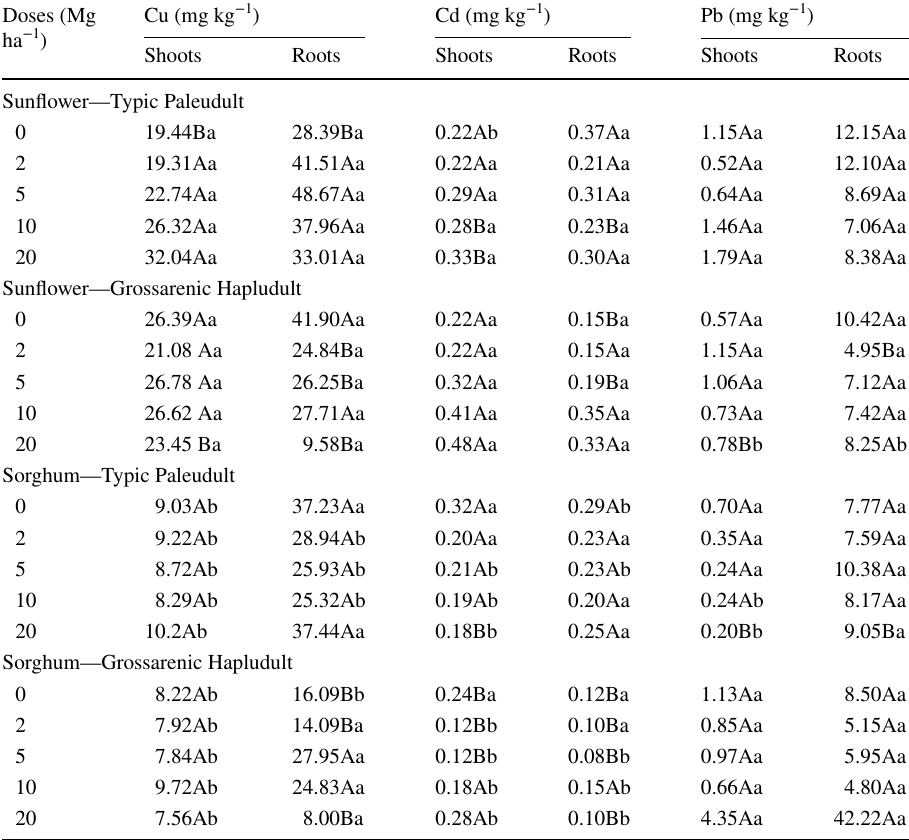
Table 2 Values of Cu, Cd, and Pb in sunflower and sorghum shoots and roots cultivated in Typic Paleudult and Grossarenic Hapludult soils under the amendment of industrial landfill sludge (ILS) at 0, 2, 5, 10, and 20 Mg ha −1